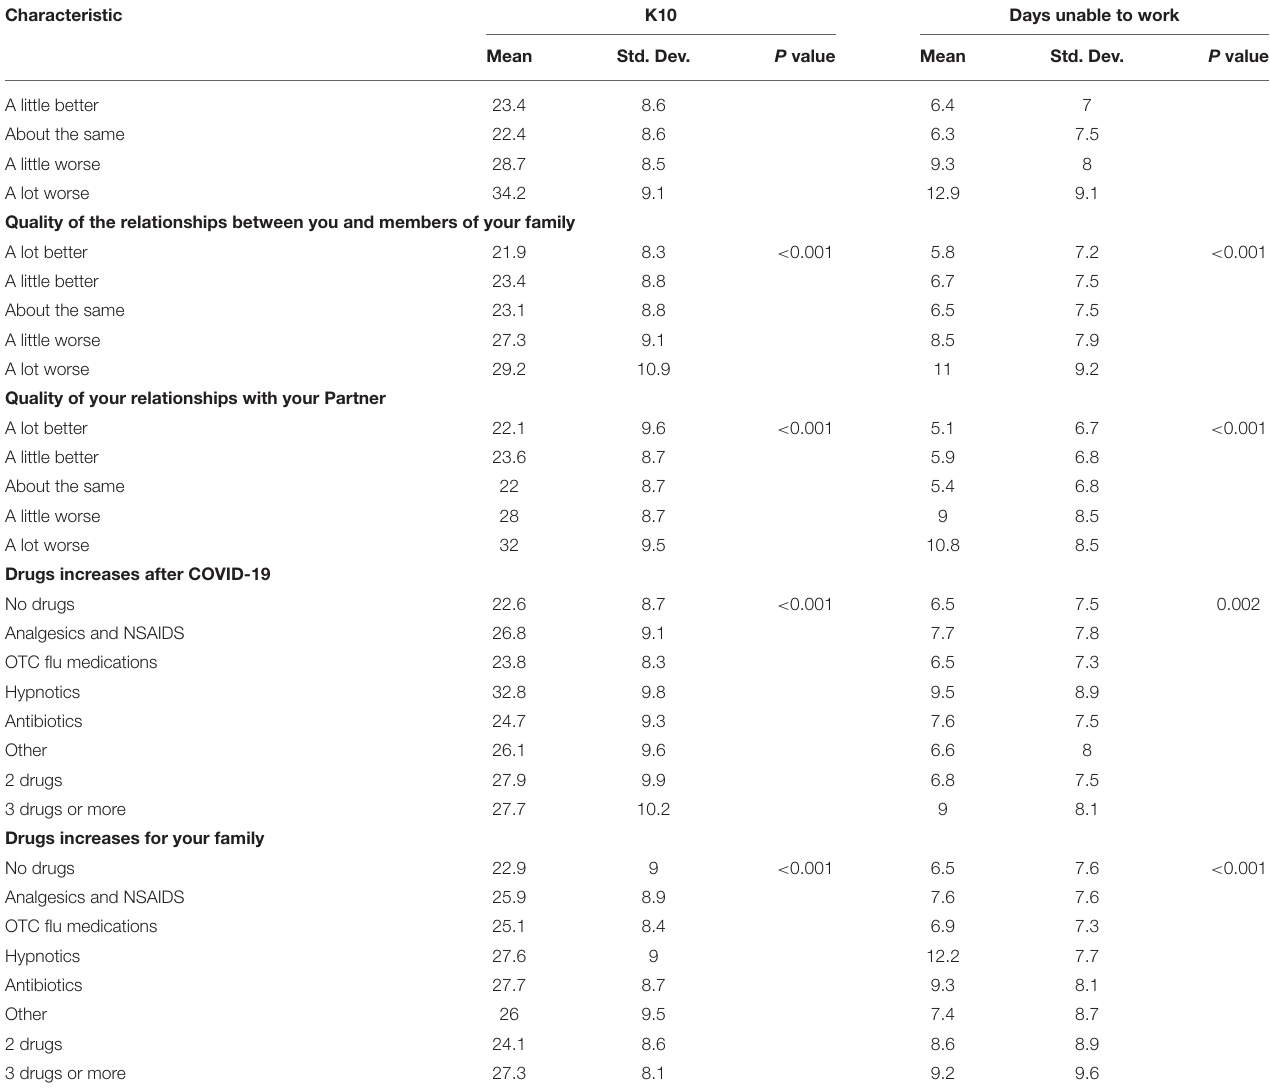
No significant difference between gender and